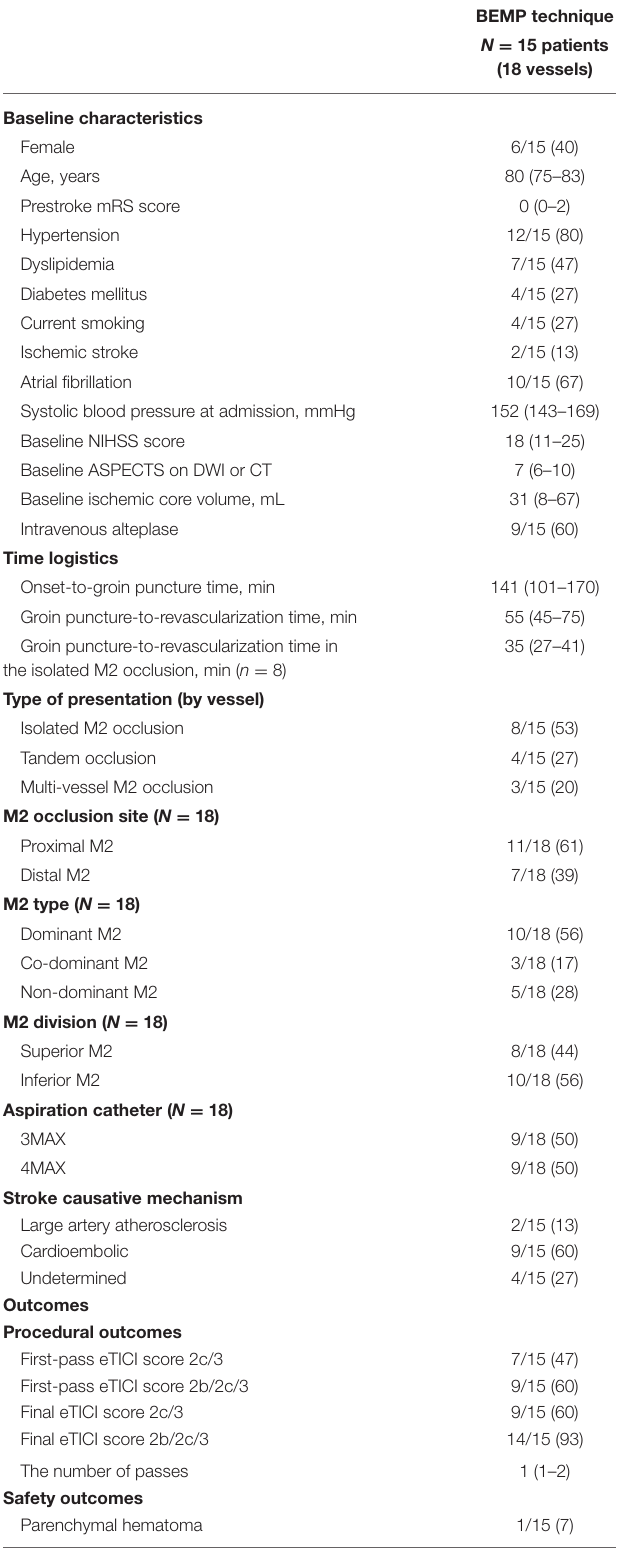
TABLE 1 | Baseline characteristics and